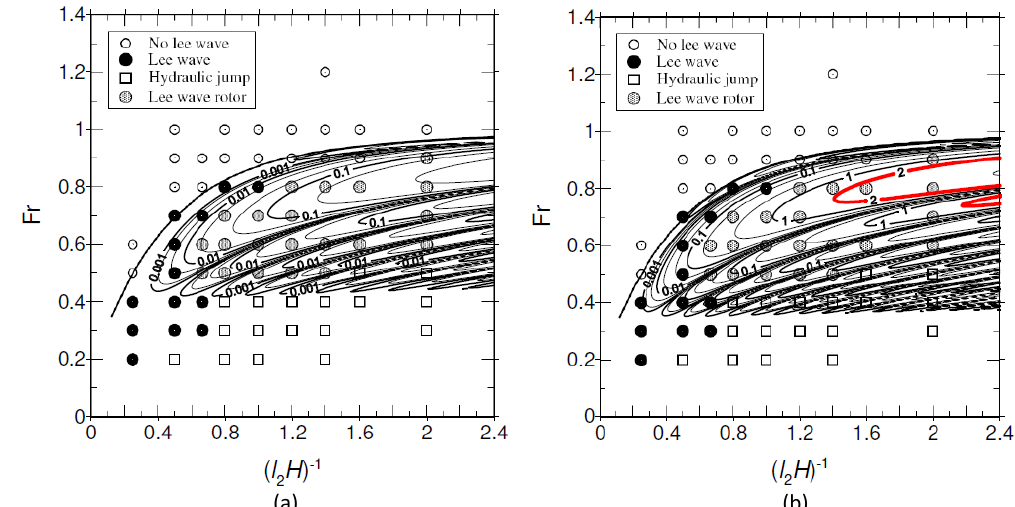
Figure 1. ( a ) and ( b ) should replace Figure 1a,b in [1].